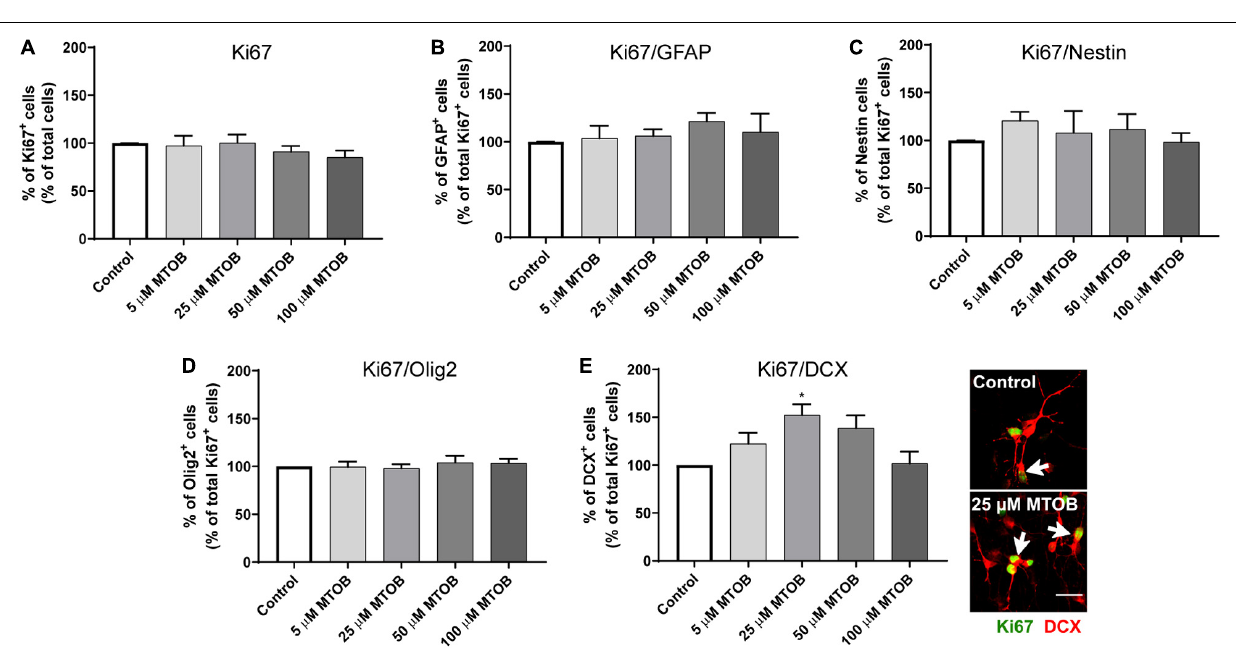
FIGURE 5 | CtBP modulation increases neuroblasts proliferation. (A) Bar graph depicts the percentage of Ki67 + cells, evaluated 48 h after MTOB treatments. (B–E) Bar graphs depict the percentages of (B) GFAP + , (C) Nestin + , (D) Olig2 + , or (E) DCX + cells co-stained with Ki67. Data are expressed as percentage of control ± SEM. (A) n = 7–9, (B) n = 2–3, (C) n = 5–6, (D) n = 3, and (E) n = 3–4 independent experiments. Control was set to 100%. * p < 0.05 when compared to control, using one-way ANOVA, followed by Dunnett’s multiple comparison test. Representative confocal images of Ki67/DCX immunostaining are shown next to the graph, with white arrows highlighting cells with double staining. Scale bar: 20 µ